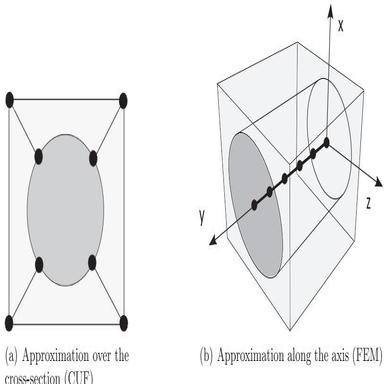
An example of discretization of the unit cell using CUF beam finite elements: the nodes along the axis illustrated in (b) represent the positions at which the nodes over the cross-section shown in (a) are repeated, for a total of 8×6 physical nodes.